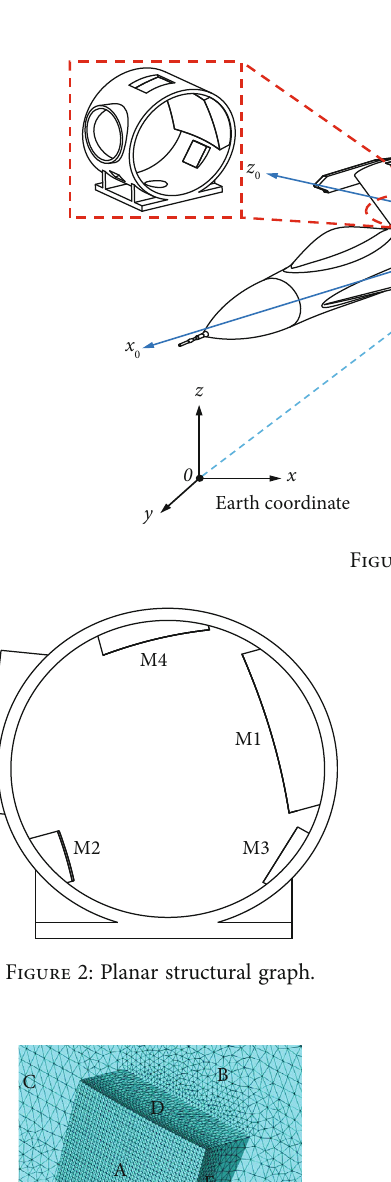
Figure 4: The distance between adjacent mirror